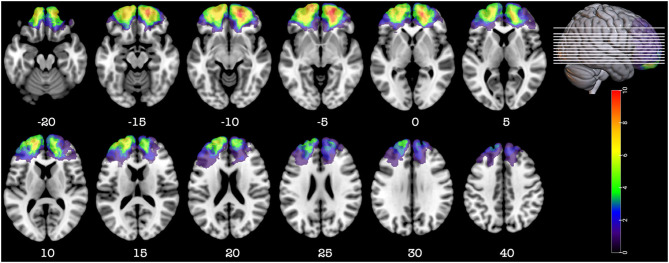
Representative axial slices depicting the lesion overlay density maps of TBI participants in the prefrontal group (n = 20). Z-values shown at the bottom of each slice indicate the z coordinates (MNI) of each axial slice represented in the 3D view of the brain by white line. The color indicates the number of veterans in the group with damage to a given voxel. Images are in radiological space (i.e., right is left).